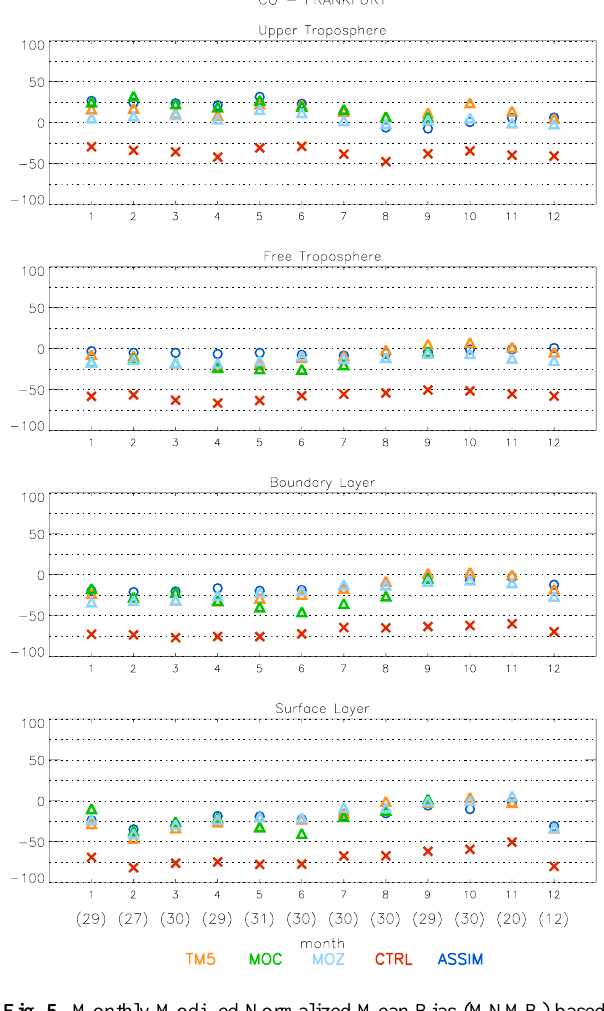
Fig. 5. Monthly Modified Normalized Mean Bias (MNMB) based on daily averaged profiles over Frankfurt. The numbers in paren- thesis at the bottom of the graph represent the number of days with available profiles.